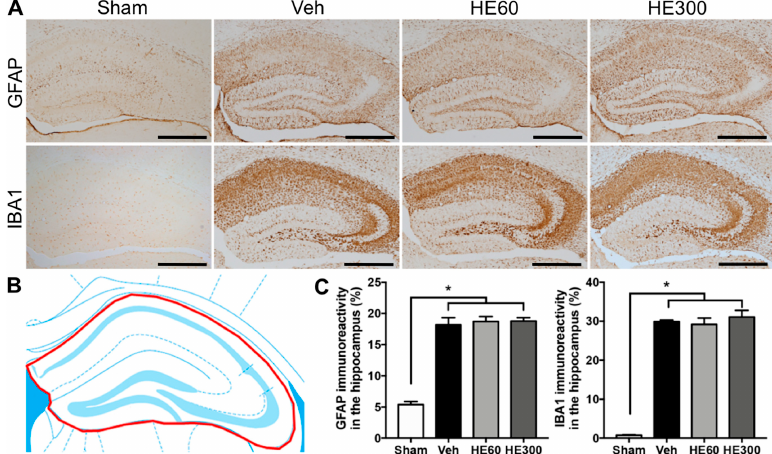
Figure 3. Reactive gliosis after pilocarpine-induced SE was not altered by either low- or high-dose HE administration. ( A ) Representative photomicrographs showing immunohistochemistry to glial fibrillary acidic protein (GFAP) and ionized calcium-binding adapter molecule 1 (IBA1) in sham, vehicle (Veh)-, 60 mg/kg HE- (HE60), and 300 mg/kg HE-treated groups (HE300). Scale bar: 500 μ m. ( B ) A drawing of the hippocampus indicating the region for the quantitative analysis of reactive gliosis (shown in red). ( C ) Graphs showing the immunoreactivity to GFAP and IBA1 in the hippocampus. Note that both GFAP and IBA1 immunoreactivity were significantly increased by SE, but there were no differences in the glial activation among Veh-, HE60-, and HE300-treated groups. Data are shown as mean ± SEM. n = 6 (sham), n = 10 (Veh), n = 8 (HE60), n = 6 (HE300). * p < 0.05; one-way ANOVA with Tukey’s post-hoc test.